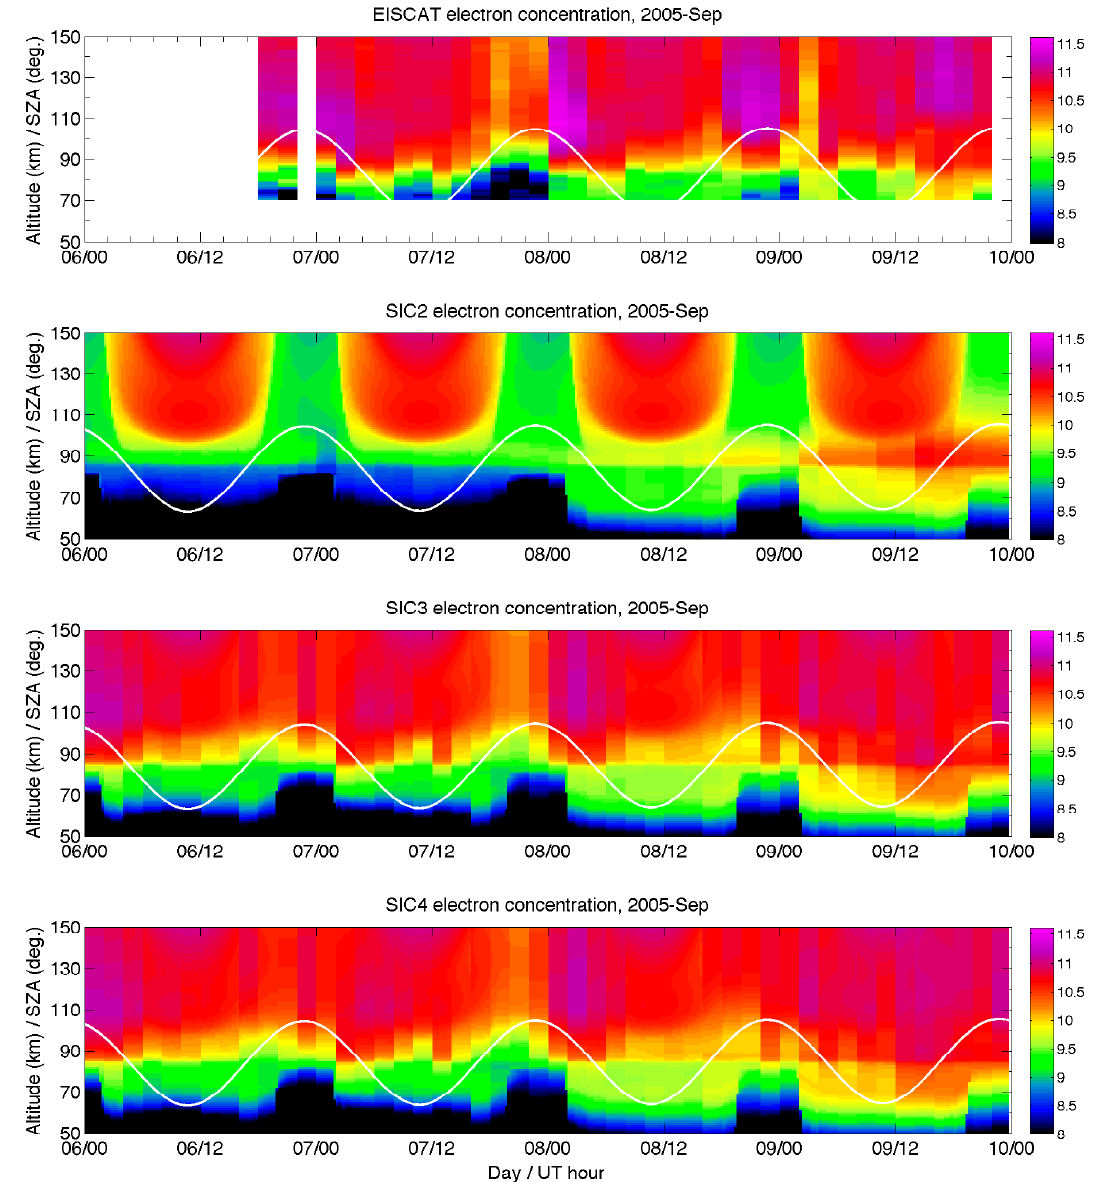
Figure 4. As Fig. 2, but for the September 2005 event (Case